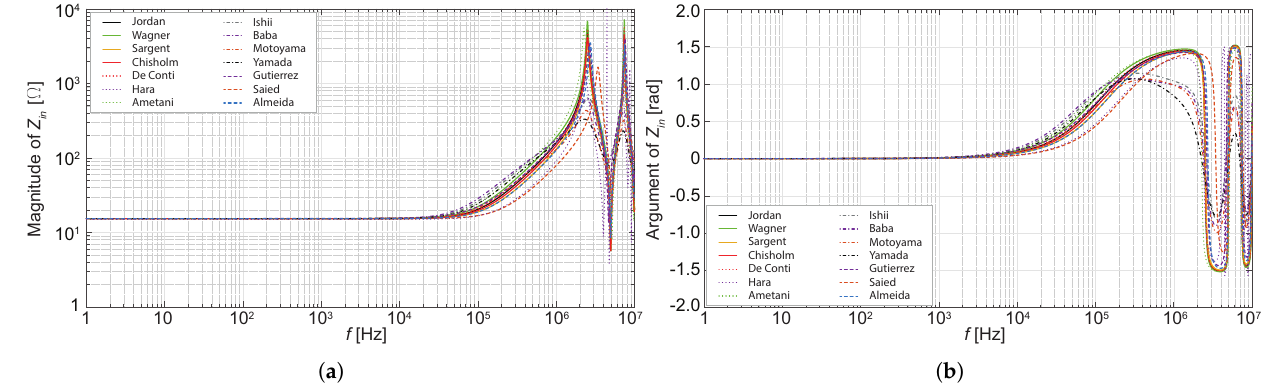
Figure 27. Input impedance Z in ( f ) seen at the top of tower (a) in Figure 16 over the soil with = 20, and Z gr ( f ) in Figure 19. ( a ) Magnitude of Z ρ g = 150 Ω m, (cid:101) r g